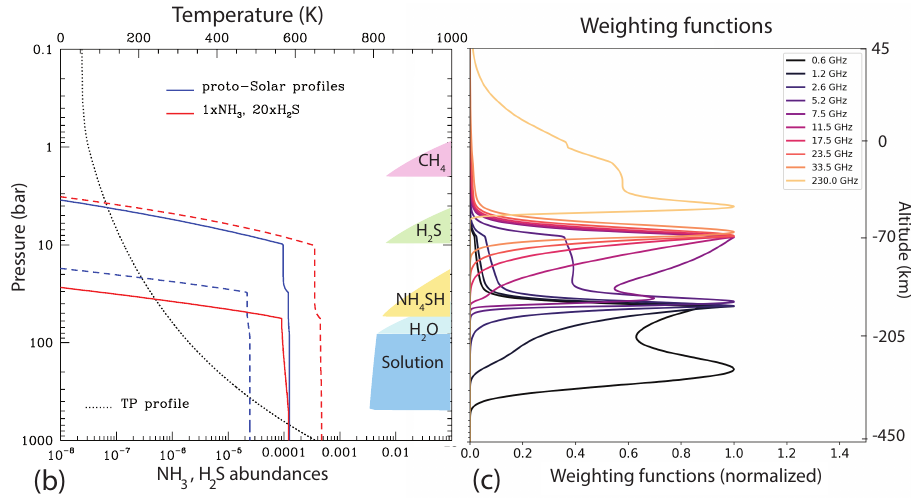
Figure 18. ( a ) Neptune’s disk-averaged brightness temperature as a function of wavelength. Red: recent ALMA and VLA data [16,27]. Black: filled circles: older VLA data [9,143,144]; open circles: single dish data (compiled in [143]); Green: WMAP [84]; Magenta: Planck collaboration [87,88]. The curves are model calculations: Blue: solar abundances for all gases; Red: abundances of CH 4 , H 2 O, and H 2 S in the planet’s deep atmosphere are enhanced by a factor of 50, 20, and 20 over solar C, O, and S, resp. NH 3 was kept at the solar N value, and is therefore removed above the NH 4 SH cloud layer. The cyan line shows the same model calculation, but without opacity by H 2 S; the magenta line shows the calculation without opacity by NH 3 . Since Neptune’s angular extent is small ( ∼ 2.3”), the WMAP data and the two longer wavelengths (0.68, 1.06 cm) Planck data have relatively large uncertainties. ( b ) NH 3 (solid lines), H 2 S (dashed lines) and the temperature profile (dotted line; wet adiabat) used in panel a . ( c ) Weighting functions for the red model in panels a , b